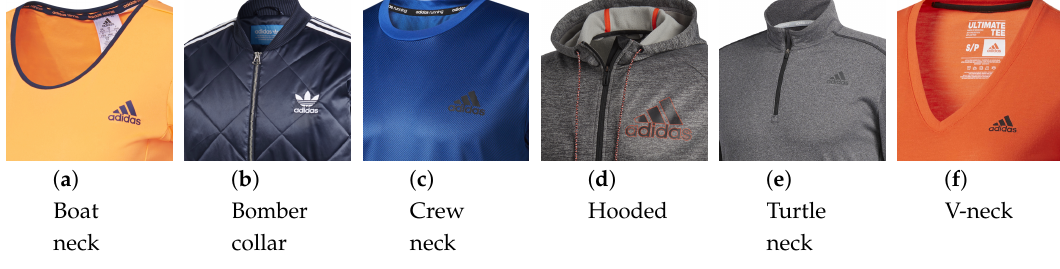
Figure 3. Types of neck shapes.